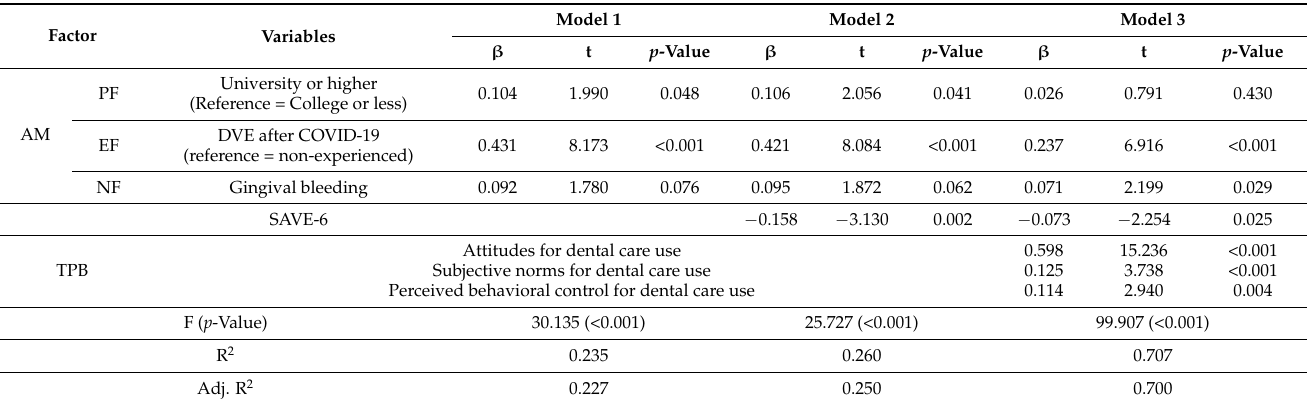
Table 4. Hierarchical multiple regression analysis of related factors affecting industrial